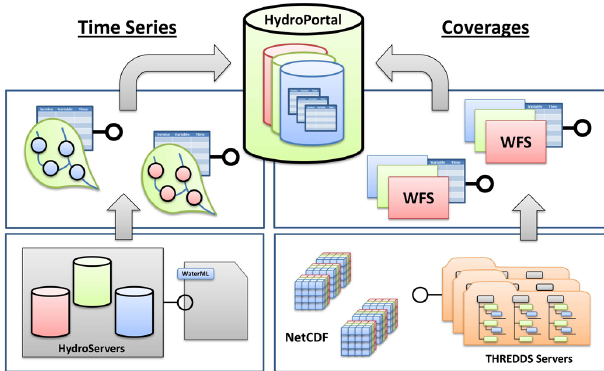
Fig. 13. Data and metadata services registered within CUAHSI-HIS